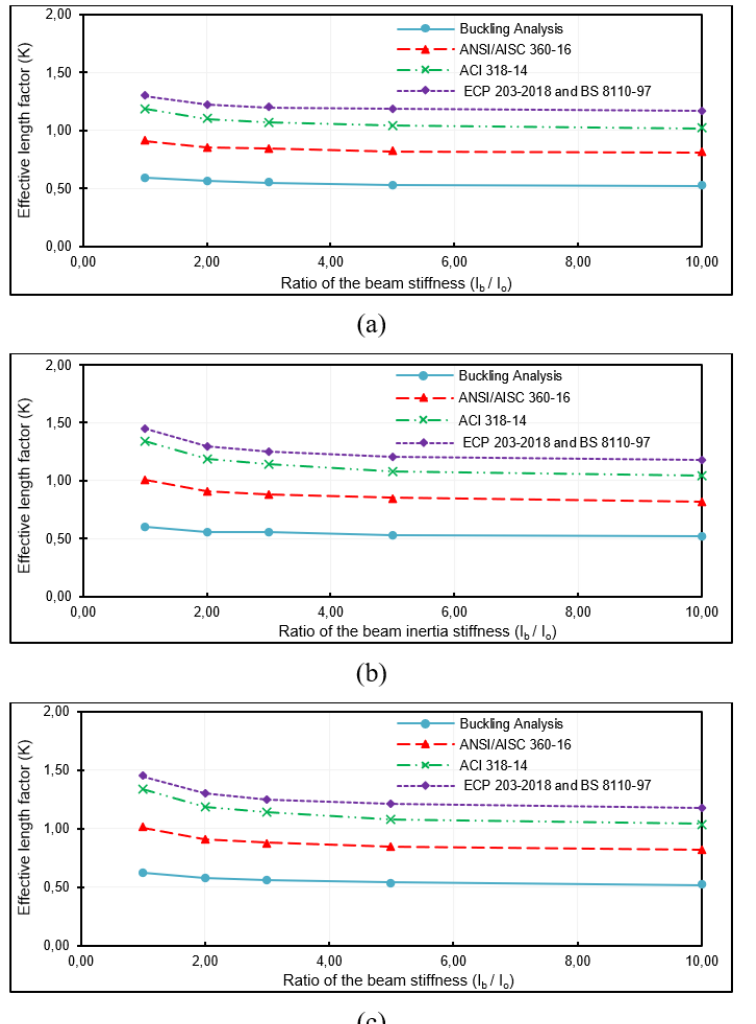
Figure 5. Relation between the effective length factor and the ratio of the beam stiffness (I b / I o ). a) one-story frames; b) two- stories frames; c) three-stories